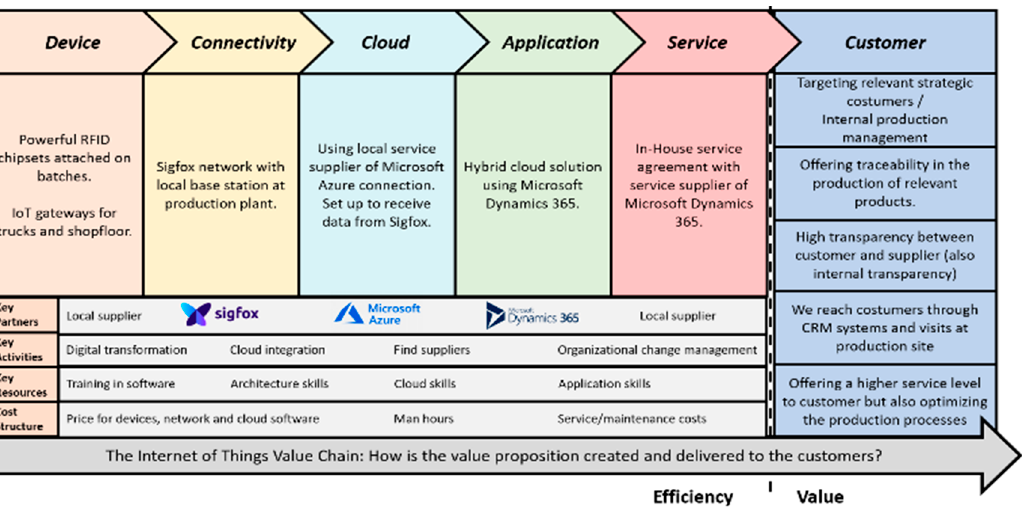
Figure 5. Value chain of IoT based Digitalization.